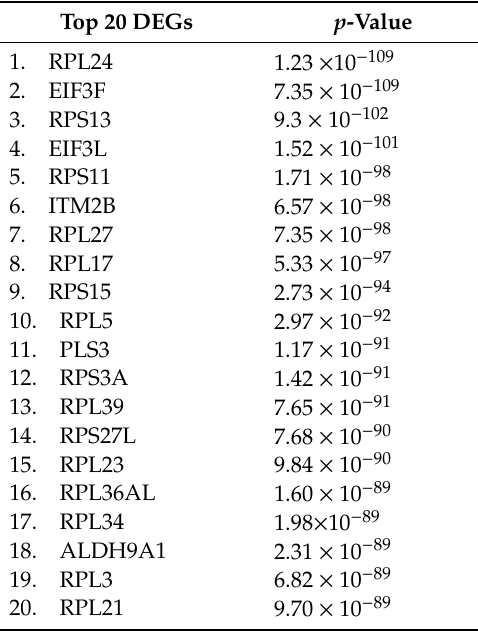
Table 2. Top 20 DEGs in our